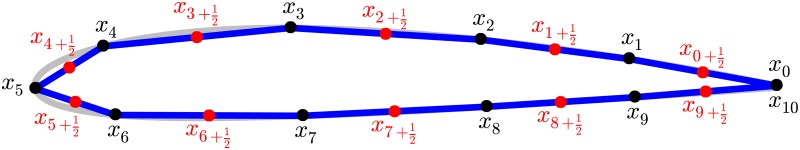
The discretized geometry of the NACA 2412 airfoil is shown (for the purpose of illustration a very coarse discretization with n = 10 is employed).The control points are shown in red and the exact geometry is outlined in gray.